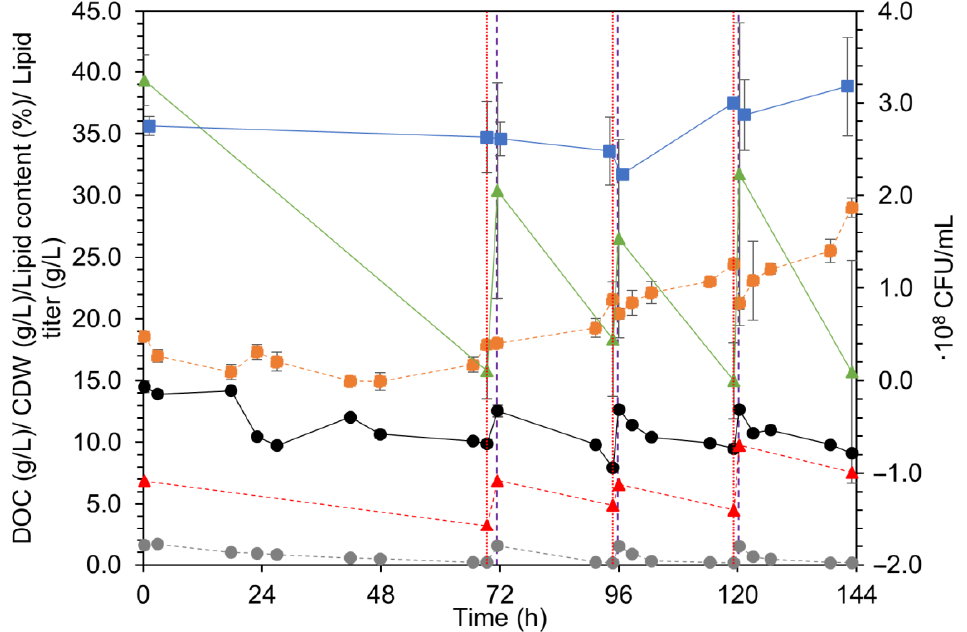
Figure 2. (-- ■ --) CDW, (- ● -) total DOC, (-- ● --) monomeric DOC as measured by HPLC, (-- ▲ --) lipid titer, (- ▲ -) lipid content, and (- ■ -) CFU for the repeated batch experiment with C. oleaginosum . Vertical lines (···) indicate the start of the harvest of the cells. Vertical lines (- - -) indicate the end of the harvest and the start of the second, third, and fourth cycle. Error bars represent the standard deviation of three analytical repeats, except for the CFU, where only two analytical repeats were performed. The monomeric substrate concentrations were measured once.